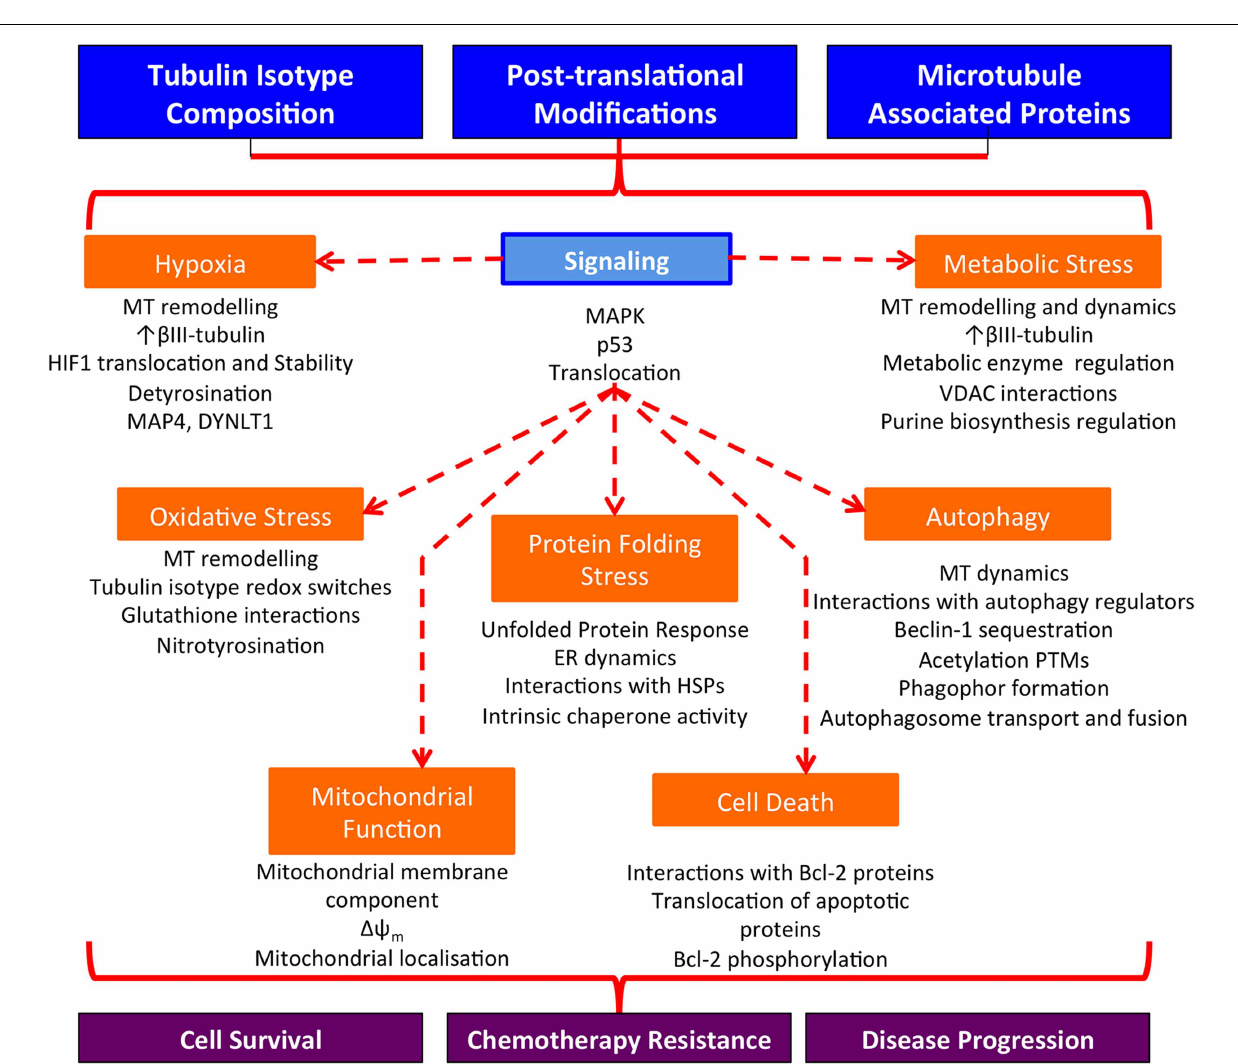
FIGURE 2 | Microtubules regulate and co-ordinate diverse cellular stress responses in cancer cells . Alterations in the expression of tubulin isotypes, tubulin post-translational modifications, and the interaction of microtubules with MAPs seen in cancer affect a wide range of homeostatic mechanisms in